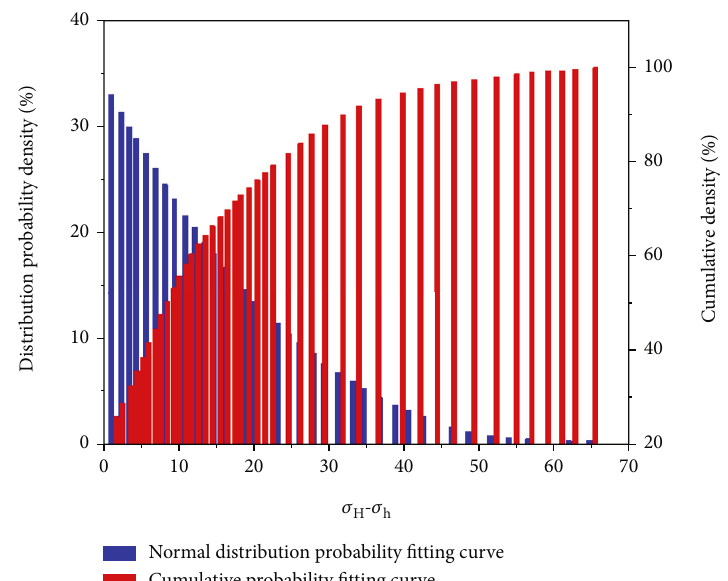
Figure 7: Probability distribution and fi tting curve of the horizontal stress di ff